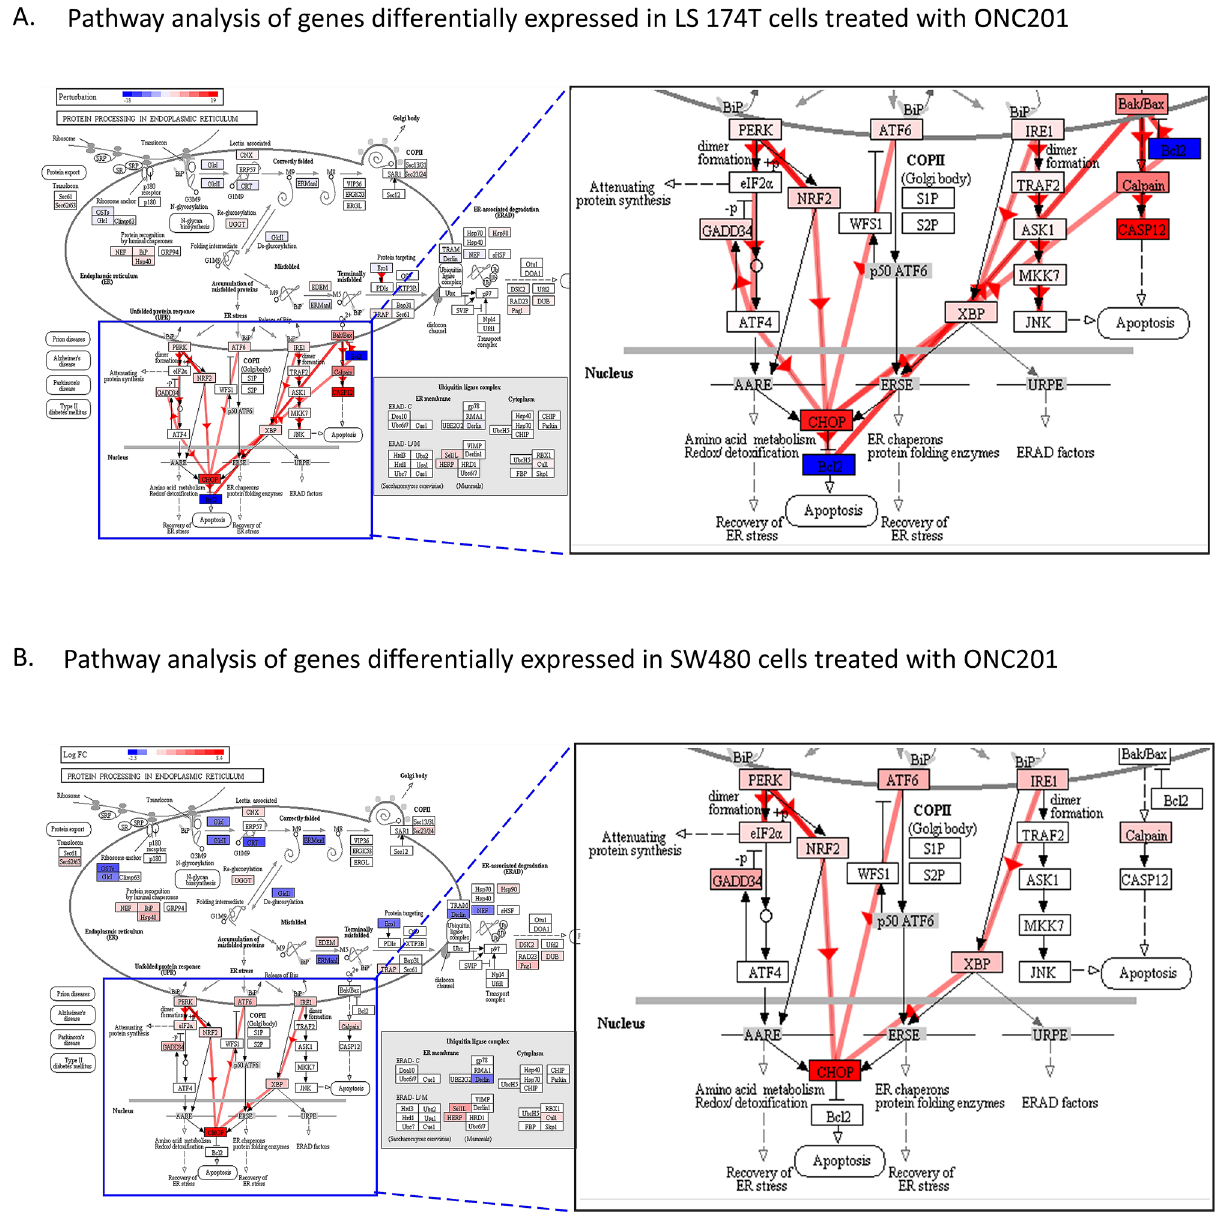
Figure 5. Schematic showing CHOP regulation in response to ONC201 treatment. ( A ) Pathway analysis of genes differentially expressed in metastatic colorectal cancer LS174T cells treated with ONC201. ( B) Pathway analysis of genes differentially expressed in nonmetastatic colorectal cancer SW480 cells treated with